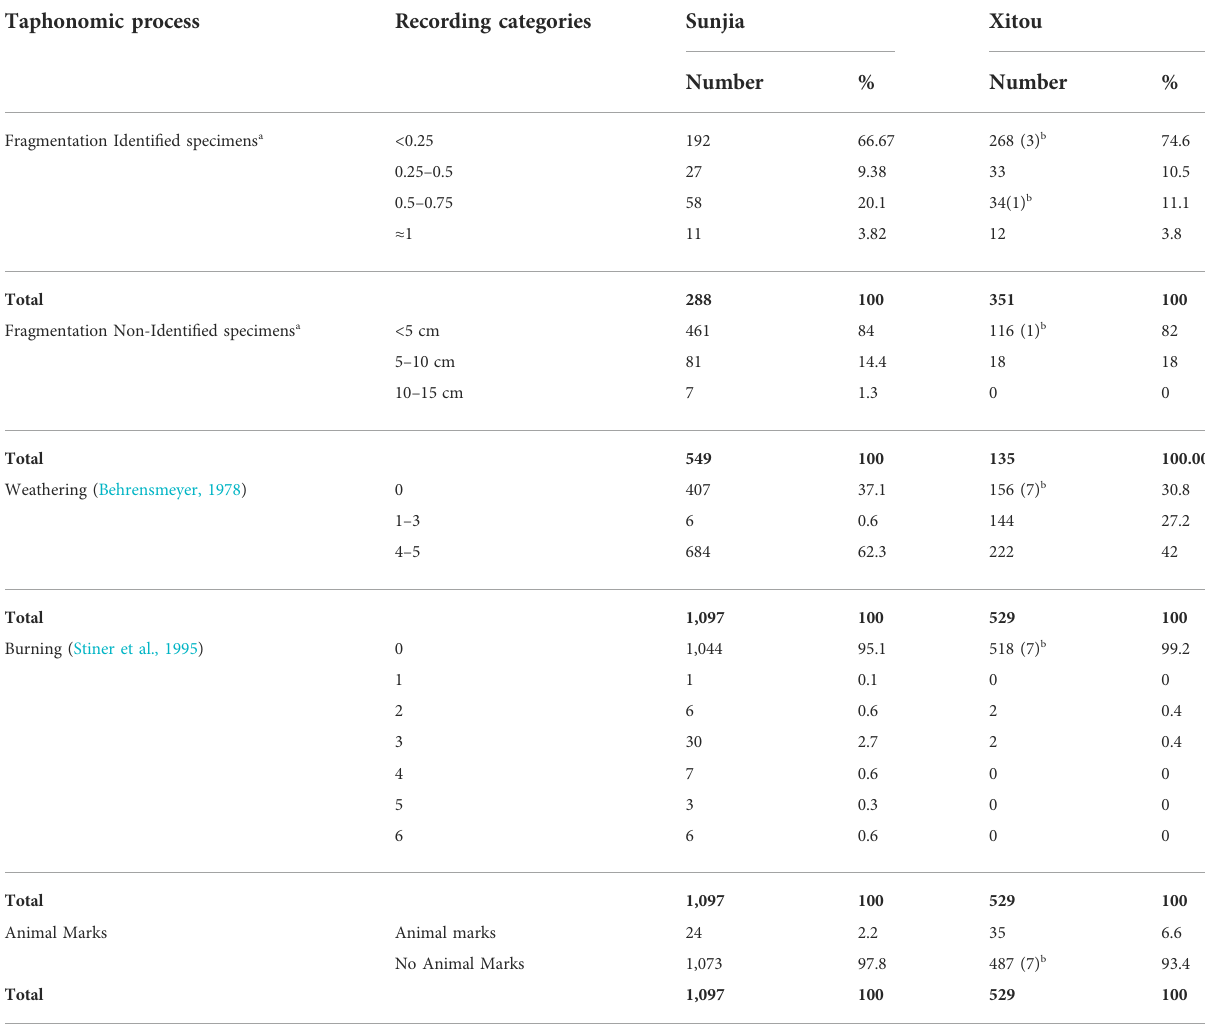
TABLE 2 Quanti fi cation of the taphonomic processes affecting the faunal remains in Sunjia and Xitou. Taphonomic